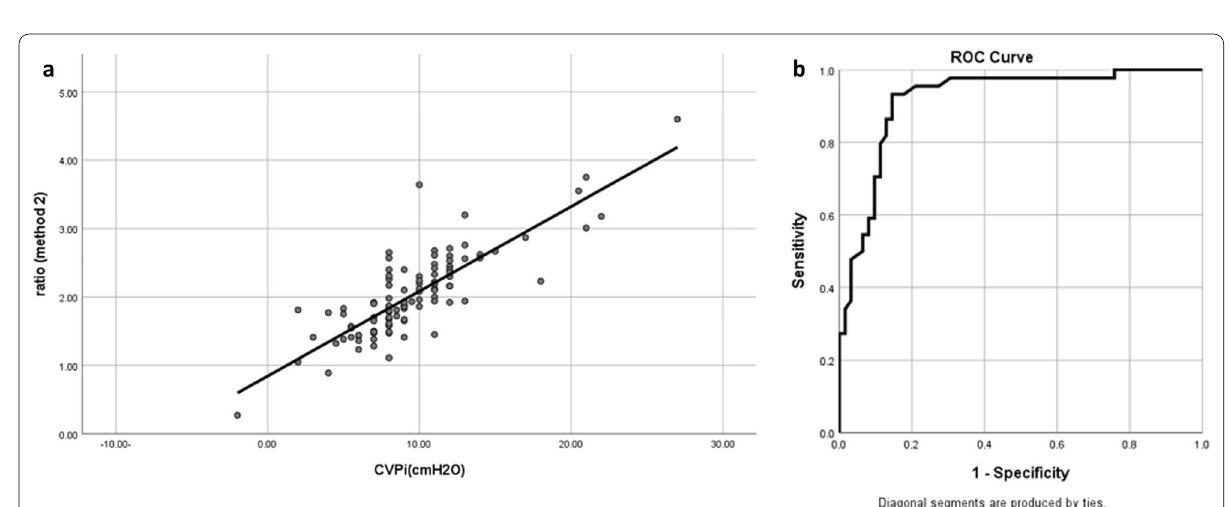
Fig. 2 a scattered plot curve for the relationship between CVPni and CVPi in method 1. b ROC curve for prediction of high CVP > method 1